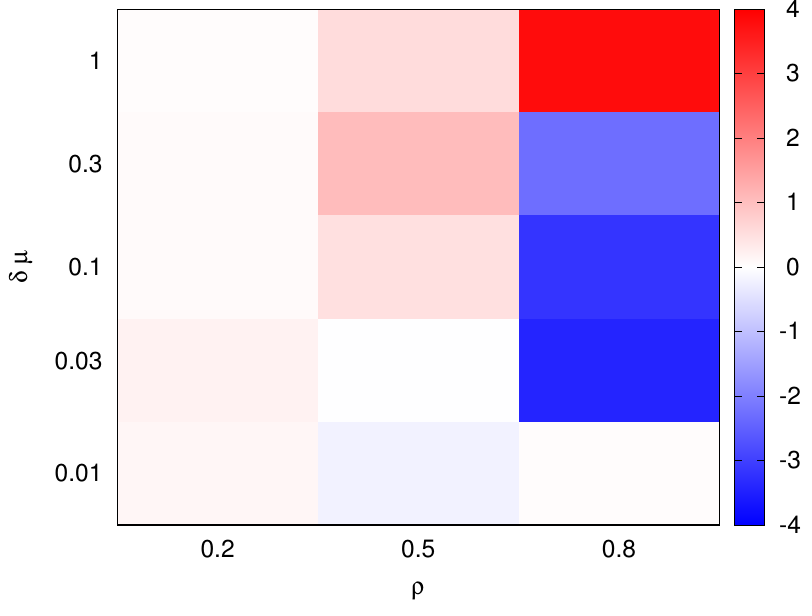
Figure 5. Performance comparison: (cid:101)